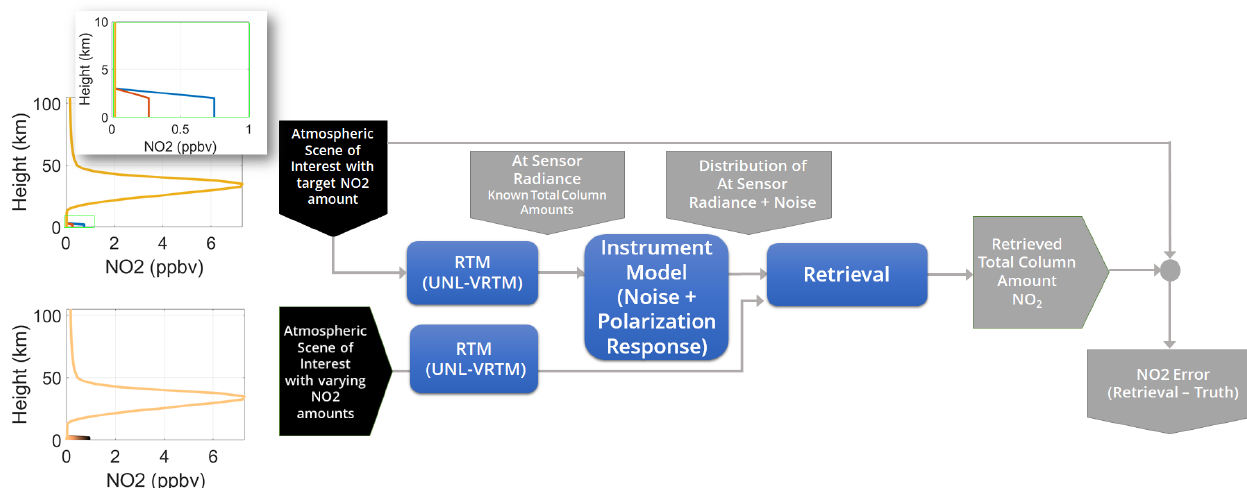
Figure 1. Simulation method for retrieving NO 2 in clear scenes: the scenes of interest consist of selected custom NO 2 profiles to represent low, medium, and high NO 2 cases shown at the upper left (including a zoomed-in view) corresponding to total vertical NO 2 amounts of 4.60, 5.93, and 8 . 44 × 10 15 molec.cm − 2 , respectively. The lower left profiles contain all profiles used in the retrieval process. The profiles are used in the radiative transfer model (RTM) called the Unified Linearized Vector Radiative Transfer Model (UNL-VRTM) to generate at-sensor radiance.